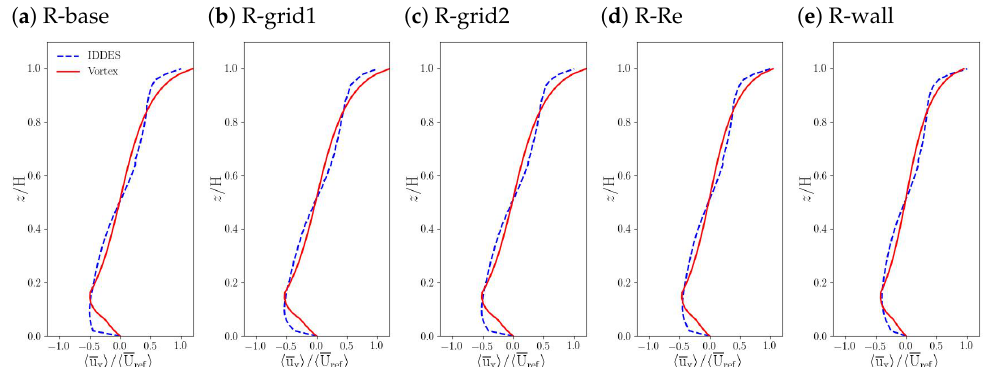
Figure A3. Vertical profiles of normalised streamwise velocities for AR = 1 and θ = 0°. Predicted profiles (solid lines) were obtained from the vortex sheet strengths of Table A4; they all show similarly good agreement with the IDDES reference (dashed lines).